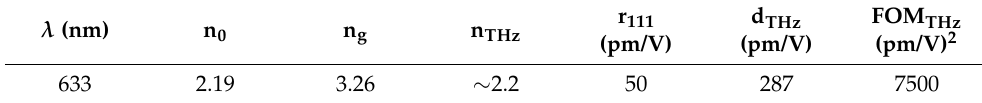
Assignment of dielectric and crystallographic axes :